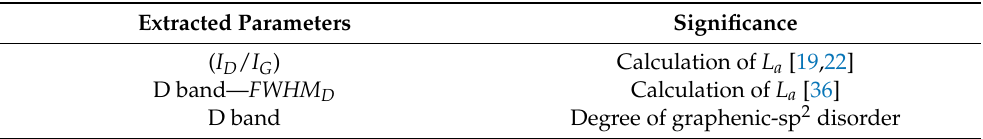
Table 1. Extracted parameters for the D and G band-fitted Raman spectra. Extracted